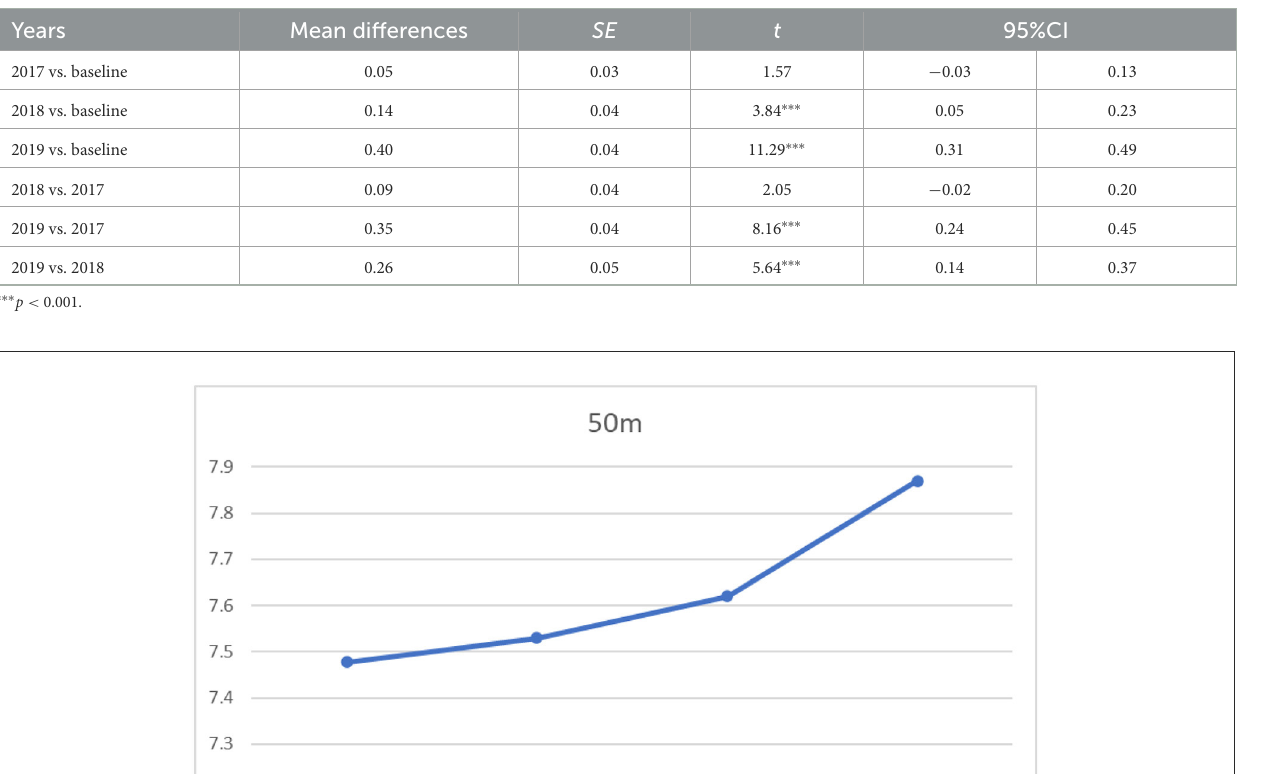
a significantly higher mean score on standing-long-jump at baseline, compare to 2017, as displayed in Table 5. Moreover, the years 2019 and 2018 had significantly higher mean scores in standing-long-jump than the year 2017. There was no significant difference in the mean score on the test of the standing-long-jump across the other years. However, there was an upward-and-downward trend from baseline to 2019, as displayed in Figure 3. For this variable, higher scores indicate better